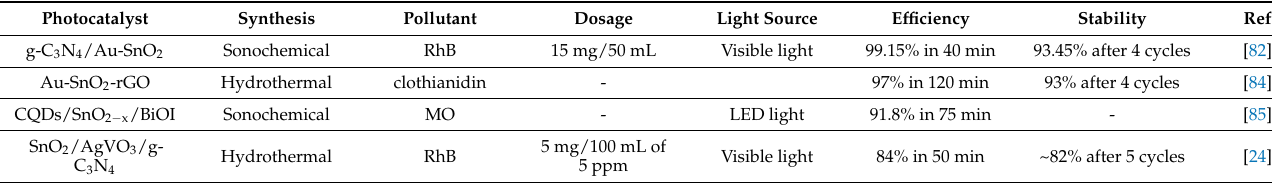
Table 4. Detailed description of recent research on the photocatalytic abilities of SnO 2 QD-based ternary